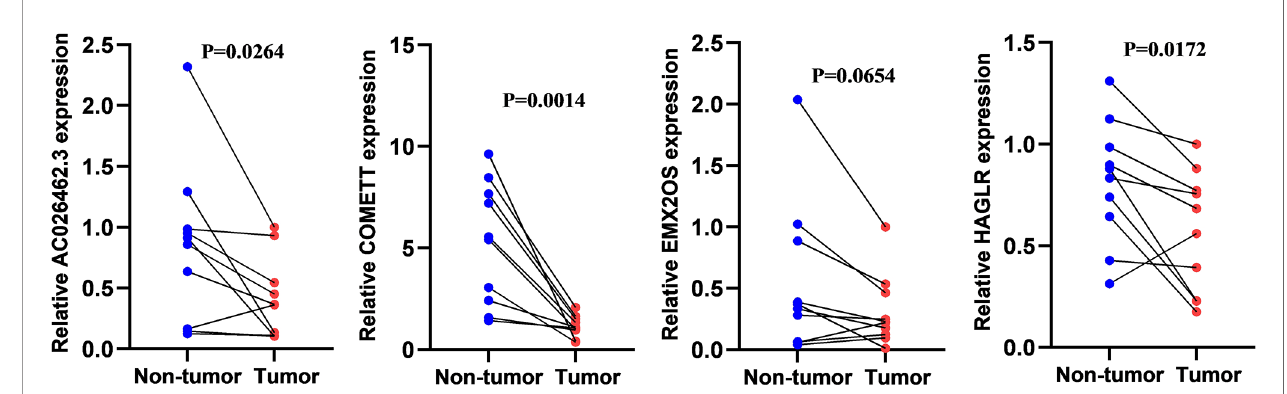
FIGURE 10 | The relative expression level of COMETT , EMX2OS , AC026462.3 , and HAGLR in ccRCC and tumor-adjacent